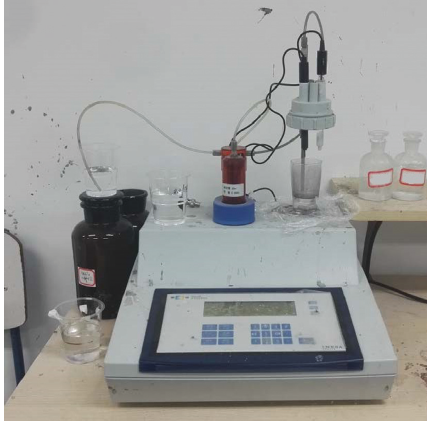
Figure 6: Automatic potentiometric titrator.